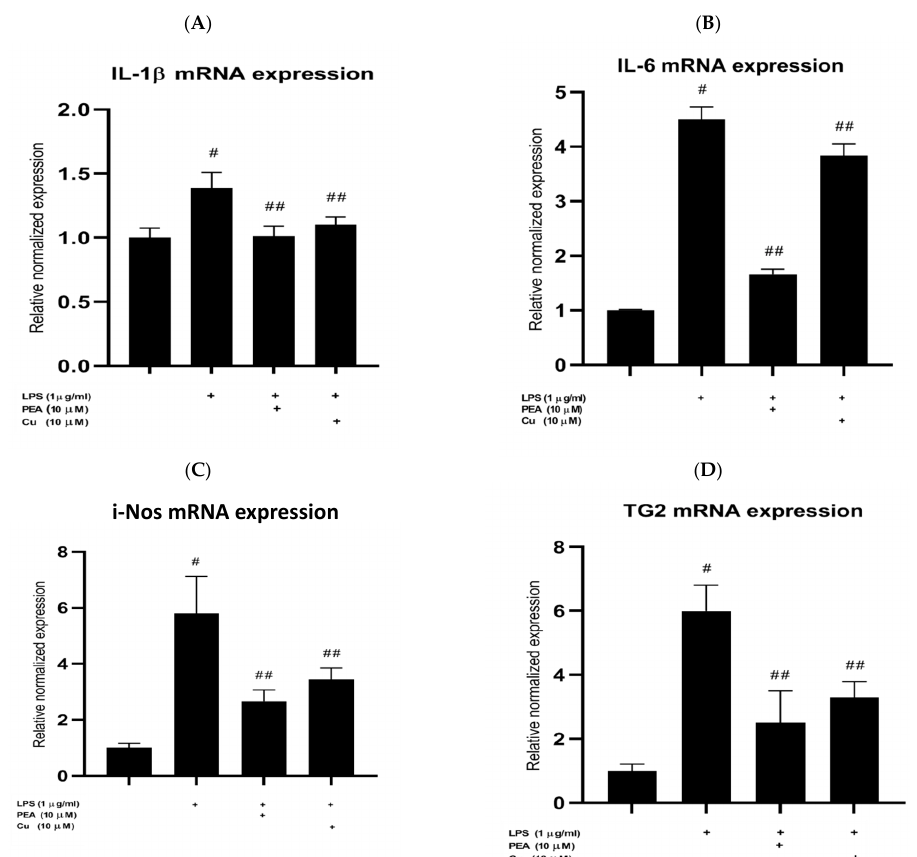
Figure 1. Real Time-PCR was performed to measure the mRNA expression of inflammatory markers after 24 h treatment. BV2 cells were pretreated with the indicated concentrations of PEA and curcumin (Cu) followed by treatment with LPS (1 µ g/mL for 24 h). Data are shown as the mean ± SD of three independent experiments. # p value < 0.05 compared with control group. ## p < 0.05 compared with LPS group.